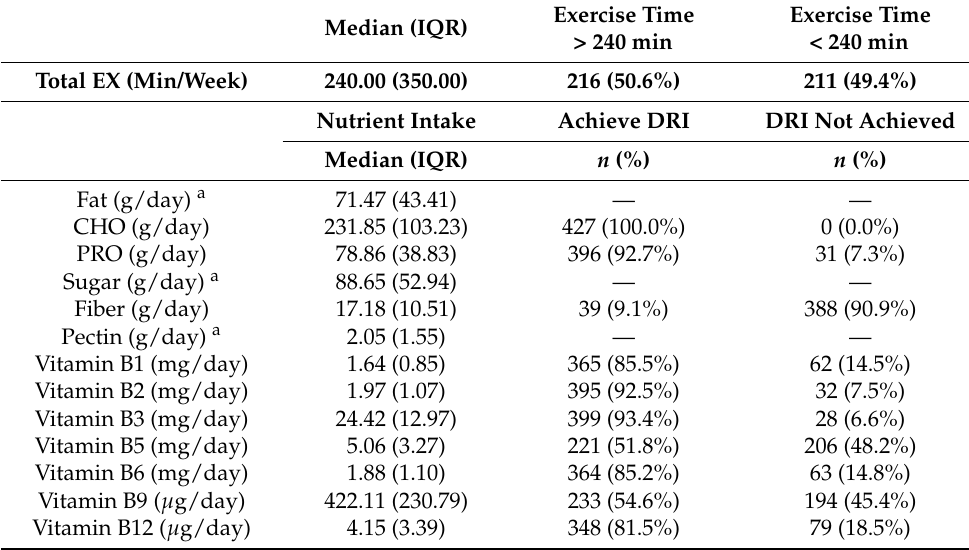
Table 3. Intake of different nutrients for different exercise